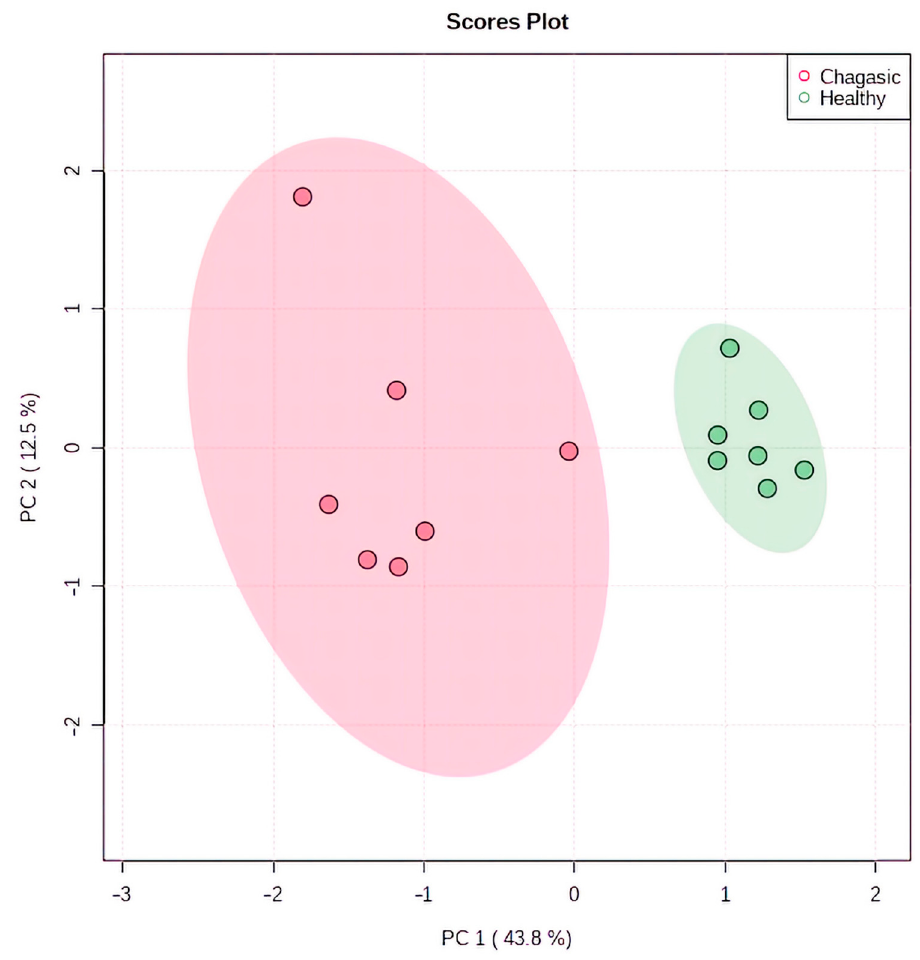
Figure 2. PCA analysis of LC/MS spectral data of cardiac tissue samples from CCC and healthy controls. Ellipses represent mean ± SD for each group.